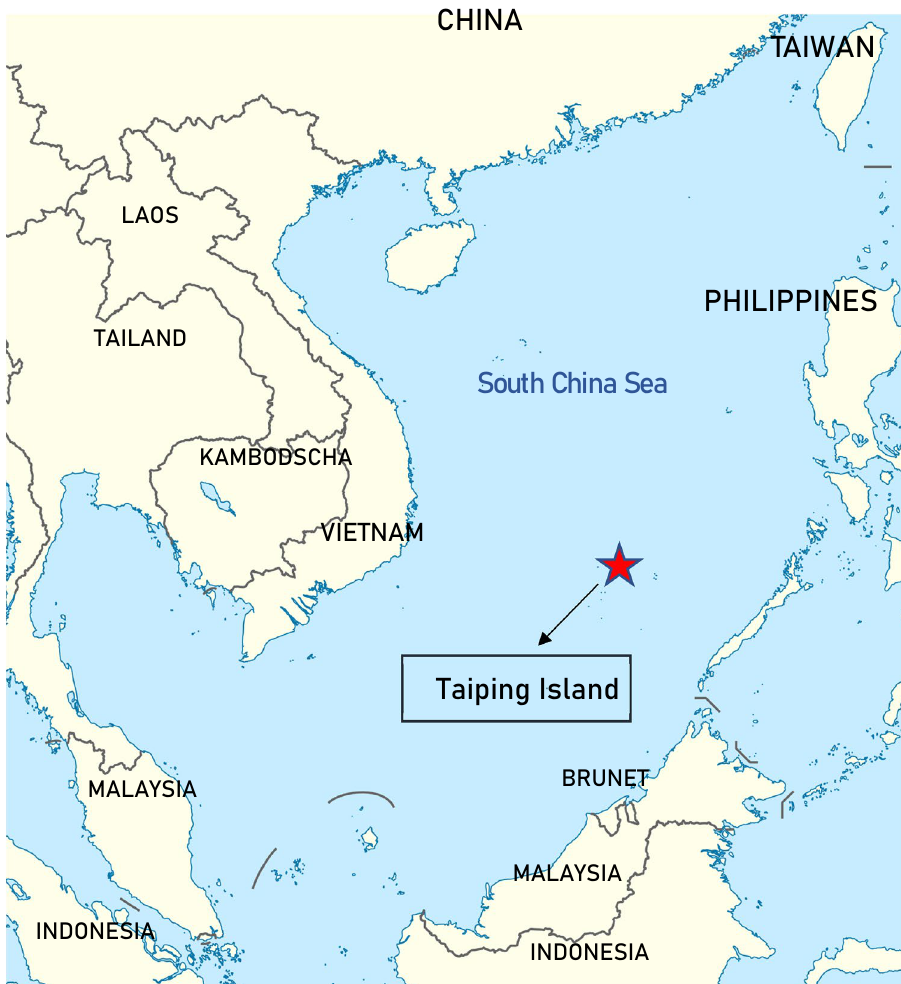
Figure 1. Location of atmospheric speciated mercury sampling site at the Taiping Island in the South China